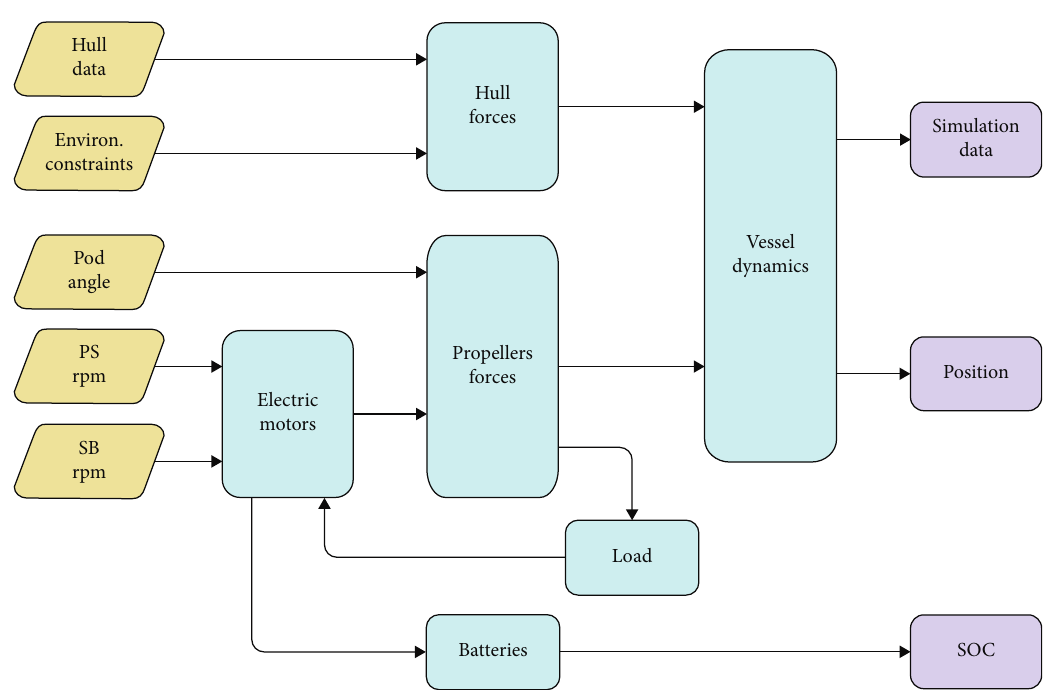
Figure 9: Vessel simulation model